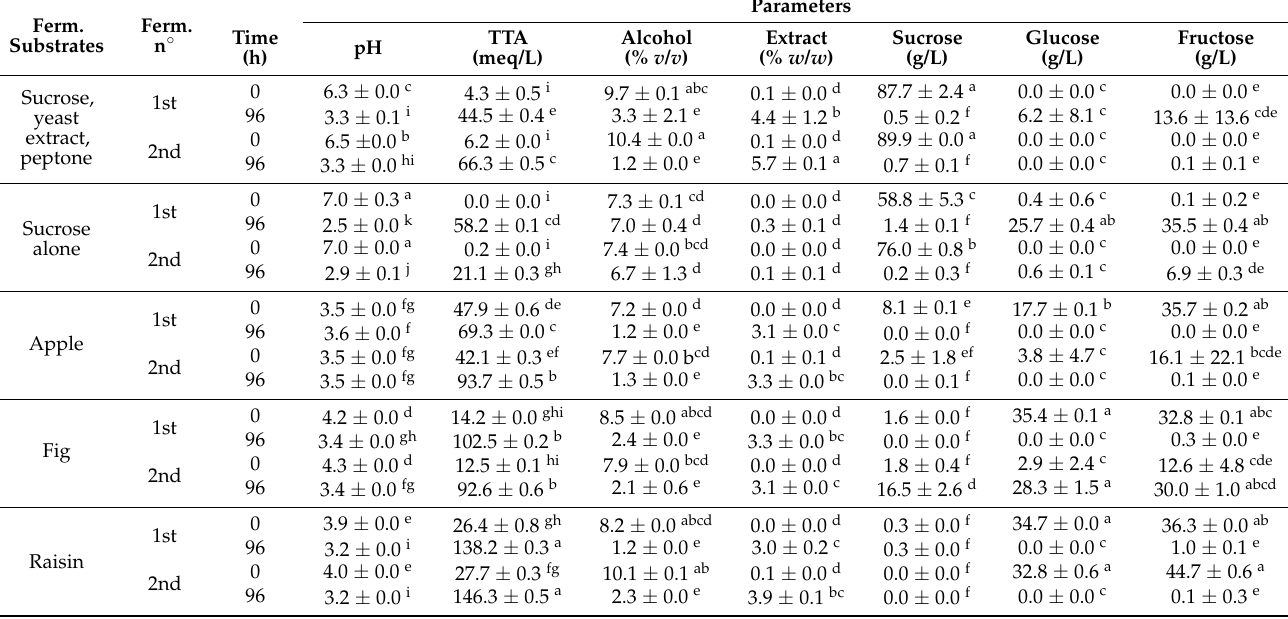
Table 1. Characteristics of fruit water kefir fermentations.